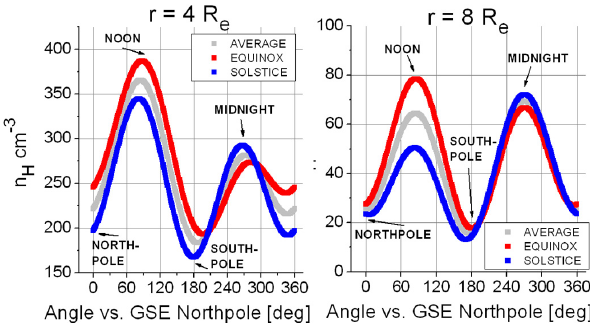
Fig. 10. Latitudinal H-density profiles for θ = 0–180 ◦ (North Pole to South Pole over noon) and θ = 180–360 ◦ (South Pole to North Pole over midnight) at 4 R E (left) and 8 R E (right) geocentric dis- tance separate for the summer-solstice- (blue), equinox- (red) and seasonal-averaged (gray) model